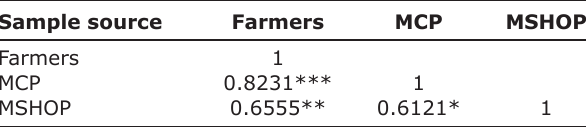
Figure-3: Susceptibility of Staphylococcus aureus from cows’ milk obtained from smallholder dairy farms in Mbeya and Mbozi districts in Tanzania to different antibiotics NB. Erythro - Erythromycin, Pen - Penicillin, Tetra - Tetracycline, Amp - Ampicillin, Enr - Enrofloxacin, Chloramp - Chloramphenicol and Sulf - Table-2: Pearson correlation for the prevalence of antimicrobial resistance for Staphylococcus aureus isolates from the milk collected along the value chain (n=10).